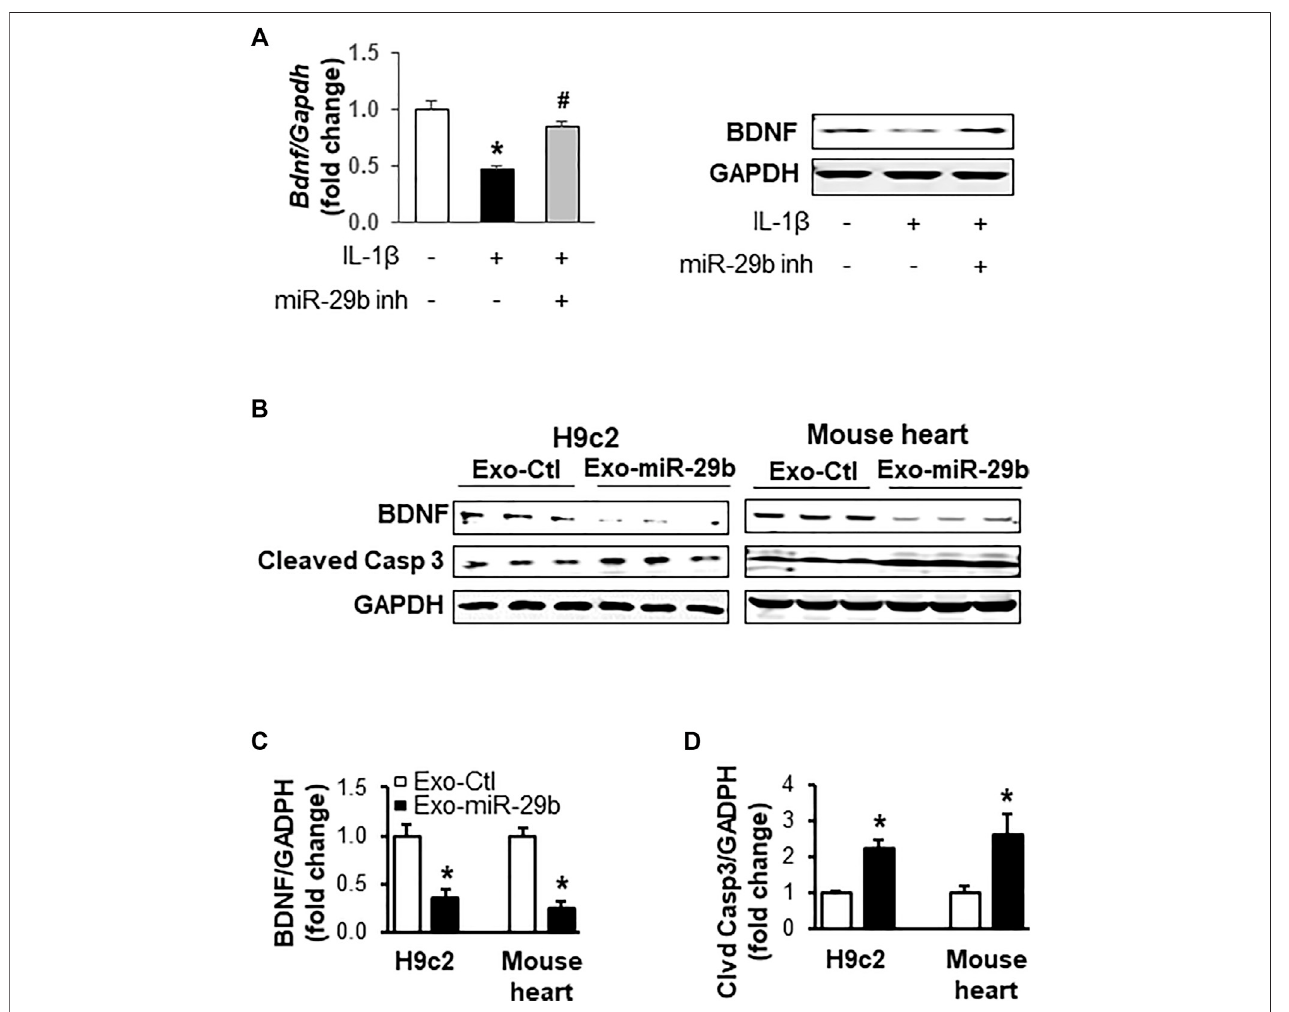
FIGURE 7 | Exosomes rich in miR-29b suppress BDNF and enhance cleaved caspase 3 in vitro (cell culture) and in vivo (mouse tail vein injection). (A) The medium from IL-1 β -treated CCD841 CoN cells suppressed BDNF mRNA (left panel) and protein levels (right panel) in H9c2 cells. CCD841 CoN cells were transfected with miR- 29b inhibitor(inh) and treatedwith10 ng/mlIL-1 β . ThemediumwithoutIL-1 β wascollected and used totreat H9c2 cellsfor 24 h. (B) Representativeimages ofWestern blots showing exosomal miR-29b decreased BDNF in vitro and in vivo . Bar graphs show the relative band densities of BDNF (C) and cleaved caspase 3 (D) after normalization to the housekeeping gene GAPDH. n = 3 independent experiments for H9c2 cells. n = 5 for in vivo experiments. * p < 0.01 vs. controls. CCD841 CoN- derivedormouse plasma exosomes weretransfectedwithmiR-29b orcontrol miRNA.TheCCD841CoN-derived exosomesloadedwithrno-miR-29b-3p mimicswere added toH9c2 cellsand incubated for 24 h,followedbyprotein isolationand Western blot analysis.Adult mice weregiven themouse exosomes transfected withmmu - miR-29b-3p mimicsor controlmiRNAthrough tail vein injection, and the animals were euthanized 24 h later. Individual hearts were collected for Western blotanalysisof